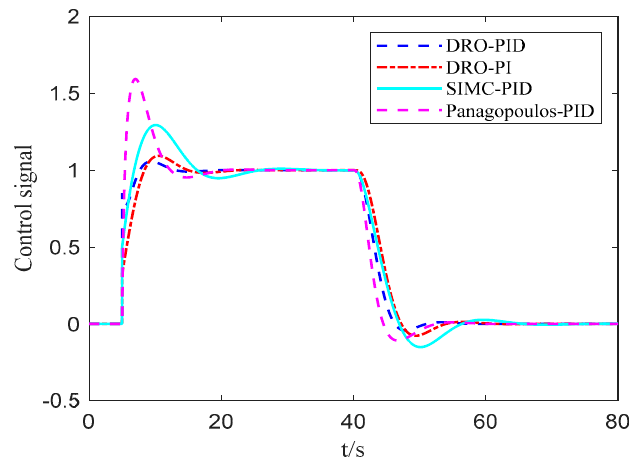
Figure 5. The control signal of the step set-point and input disturbance for Example 1.